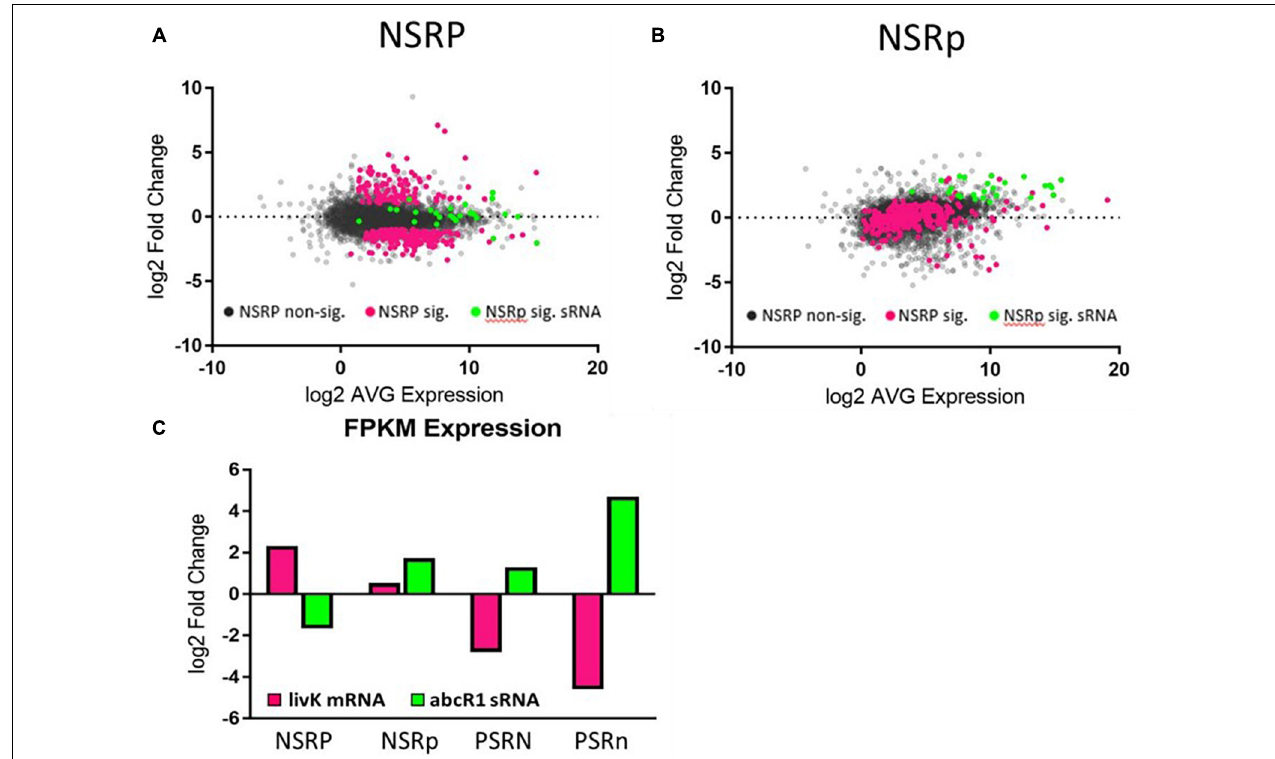
FIGURE 3 | Nitrogen stress affects sRNA expression differently under high and low phosphate. Graphs showing the changes in expression of genes in the (A) NSRP and (B) NSRp. Gray dots represent non-significant gene expression changes. Pink dots represent the set of genes that were significantly changed in the NSRP. Green dots represent the sRNAs that were significantly changed in the NSRp. The expression patterns of each group can be seen changing between the high P condition (A) and the low P condition (B) . (C) The levels of livK and abcR1 expression under the various stress conditions demonstrate the different expression patterns of an mRNA and its regulatory